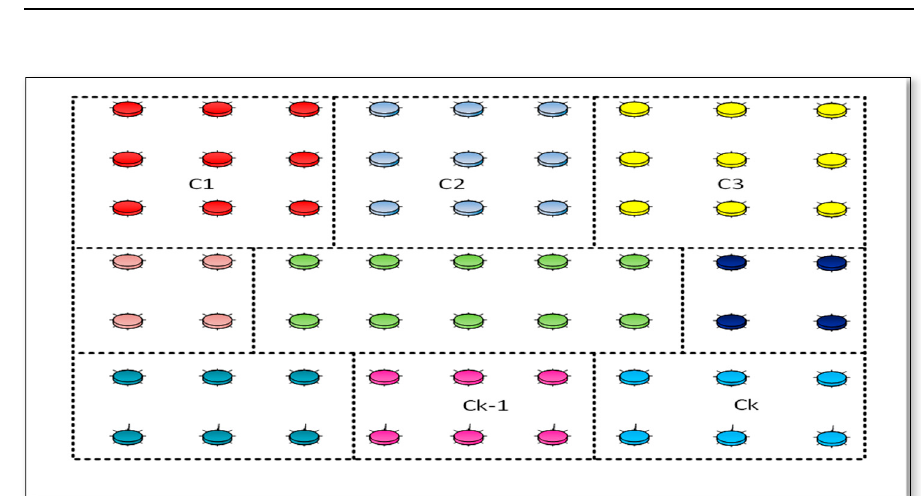
Figure 6. K-means clustering Technique.